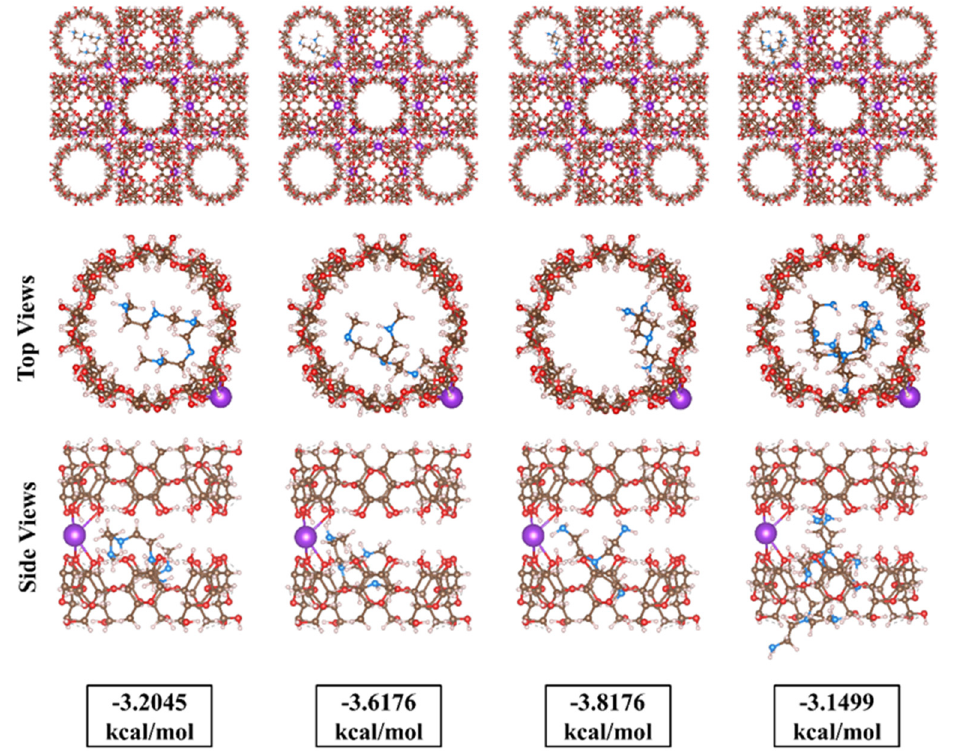
Figure 8. Complex structures of the PEIs and γ -CD-MOF. The first column from left is for the docking of linear PEI, while the other three columns are for branched PEIs. The complexity and molecular sizes of the branched PEIs increase from left to right. Atoms of H, C, O, N and K are shown as pink, brown, red, blue and purple, respectively.